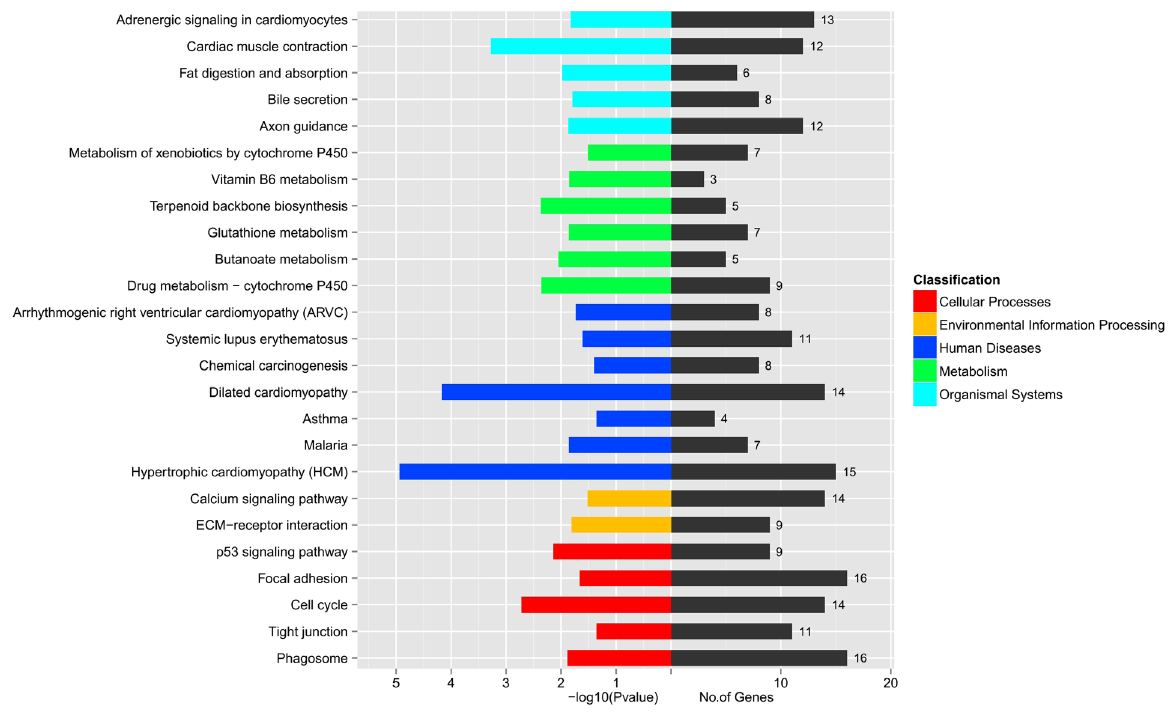
Figure 3: Kyoto Encyclopedia of Genes and Genomes pathway analysis of differentially expressed mRNAs between the model group and the treatment group